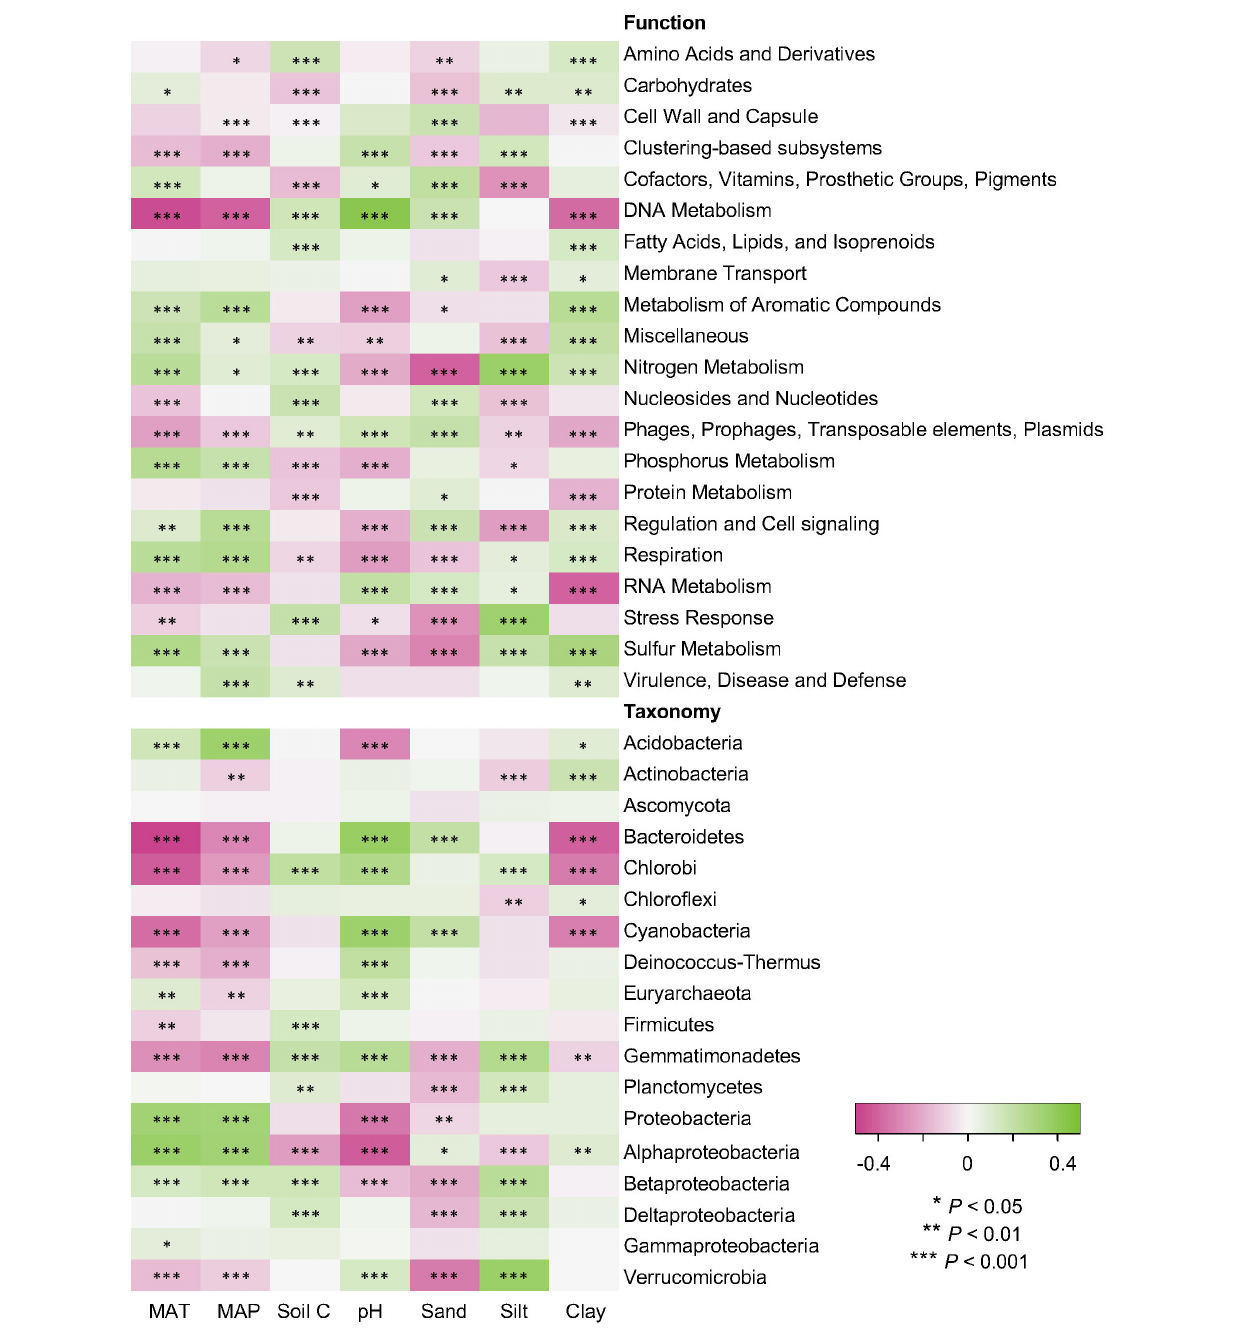
FIGURE 5 | Relations of functional and taxonomic compositions with climate data and soil properties. Heatmaps showing Pearson’s correlations of MAT and MAP data (Climate) and soil properties of C, pH, sand, silt, and clay (Soil) with relative abundance of dominant soil metagenomes (mean > 0.5%) annotated in the SEED Subsystems database at Level 1 (Function) and RefSeq database at phylum/class levels (Taxonomy). The ∗ , ∗∗ , and ∗∗∗ indicate significant relationship at α = 0.05, 0.01, and 0.001, respectively.